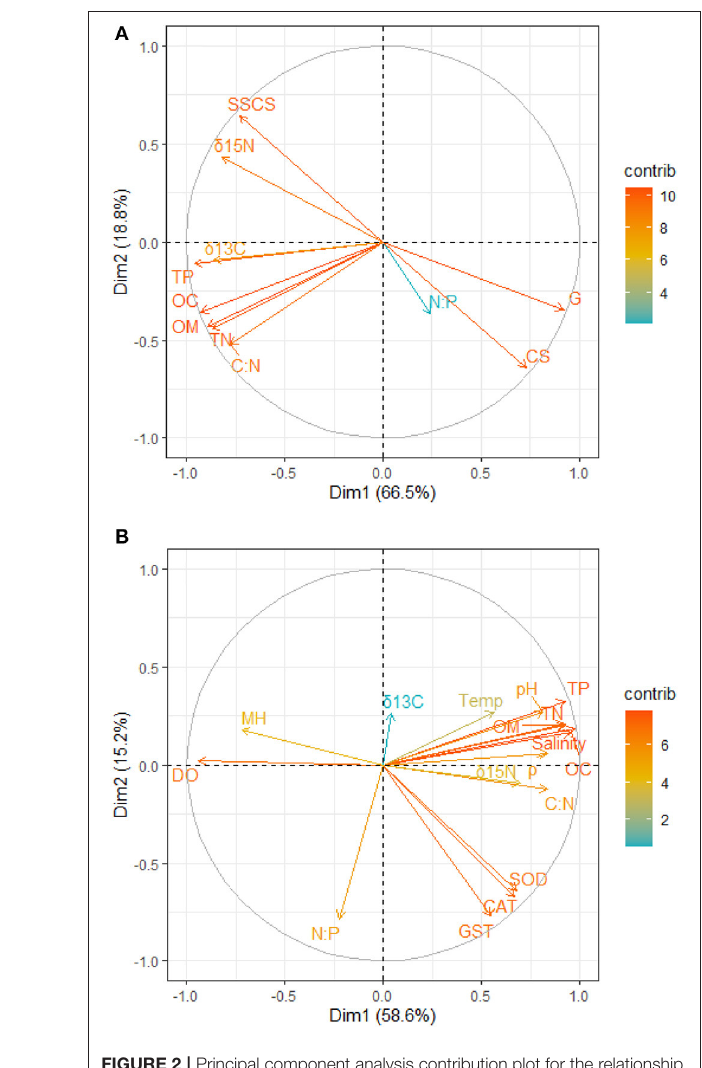
variation was highest at S8 ( Figure 4A ). Clay and silt percentages have a big impact on C/N, nutrients and δ 15 N in the sediments, while coarse fractions in sediments influence N/P ( Figures 2A , 3A ). Site S8 has the highest N and P concentrations in sediments, branches and leaves ( Table 2 ), and highest C/N ratio (15.28) and lowest N/P ratio (1.03) in sediments, and the lowest C/N and N/P ratio for mangrove tissues ( Table 3 ).